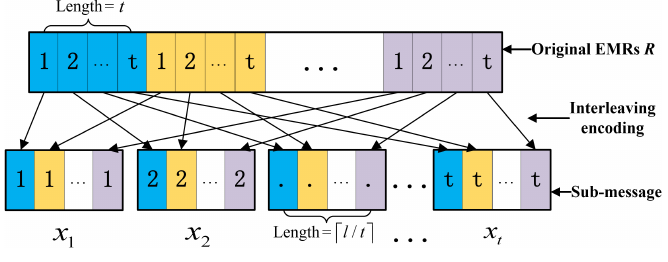
Figure 3. The principle of the interleaving